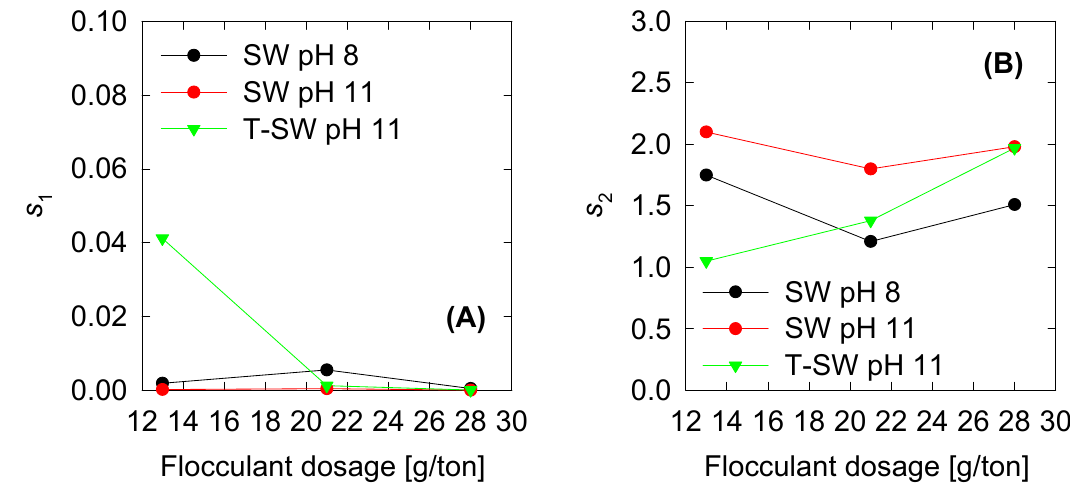
Figure 6. Optimum breakage parameters vs. shear rate for constant and variable fractal dimension: ( A ) S1 and ( B ) collision efficiency decay constant k d